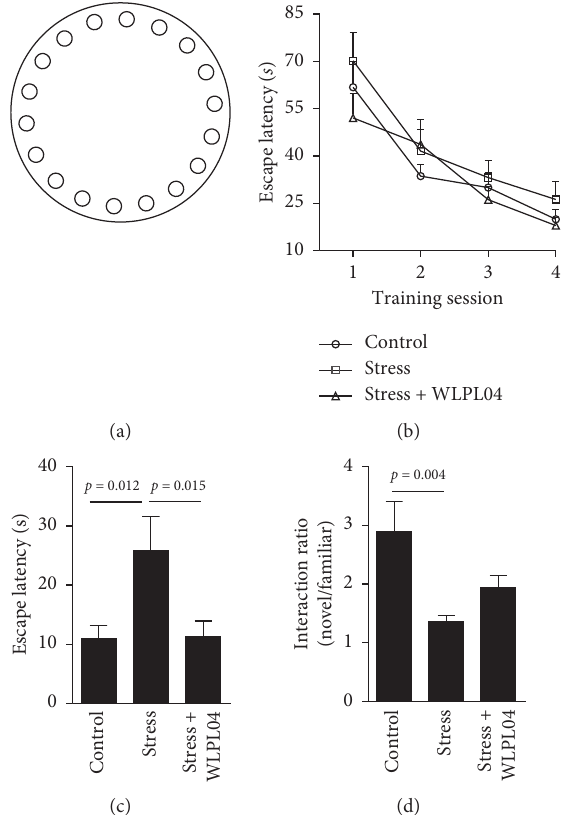
Figure 1: L . plantarum WLPL04 treatment alleviates the cognitive dysfunctions in chronically stressed mice. (a) Diagram of Barnes maze. (b), (c) Chronic stress impairs spatial memory but not spatial learning in the Barnes maze, and such memory deficit is rescued by the L . plantarum WLPL04 treatment. (d) Chronic stress impairs the novel/familiar object recognition, and such deficit is reversed by the L . plantarum WLPL04 treatment. n � 7 mice per